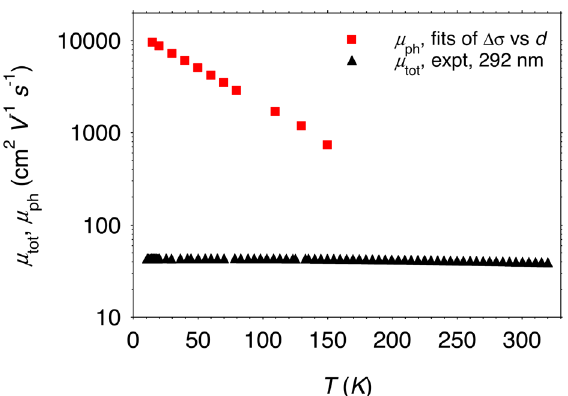
Fig. 5 Temperature dependence of total mobility and phonon-related contribution. Black triangles: total Hall mobility μ tot measured for 292-nm- thick sample. Red squares: calculated mobility μ ph due to inelastic electron – phonon scattering.